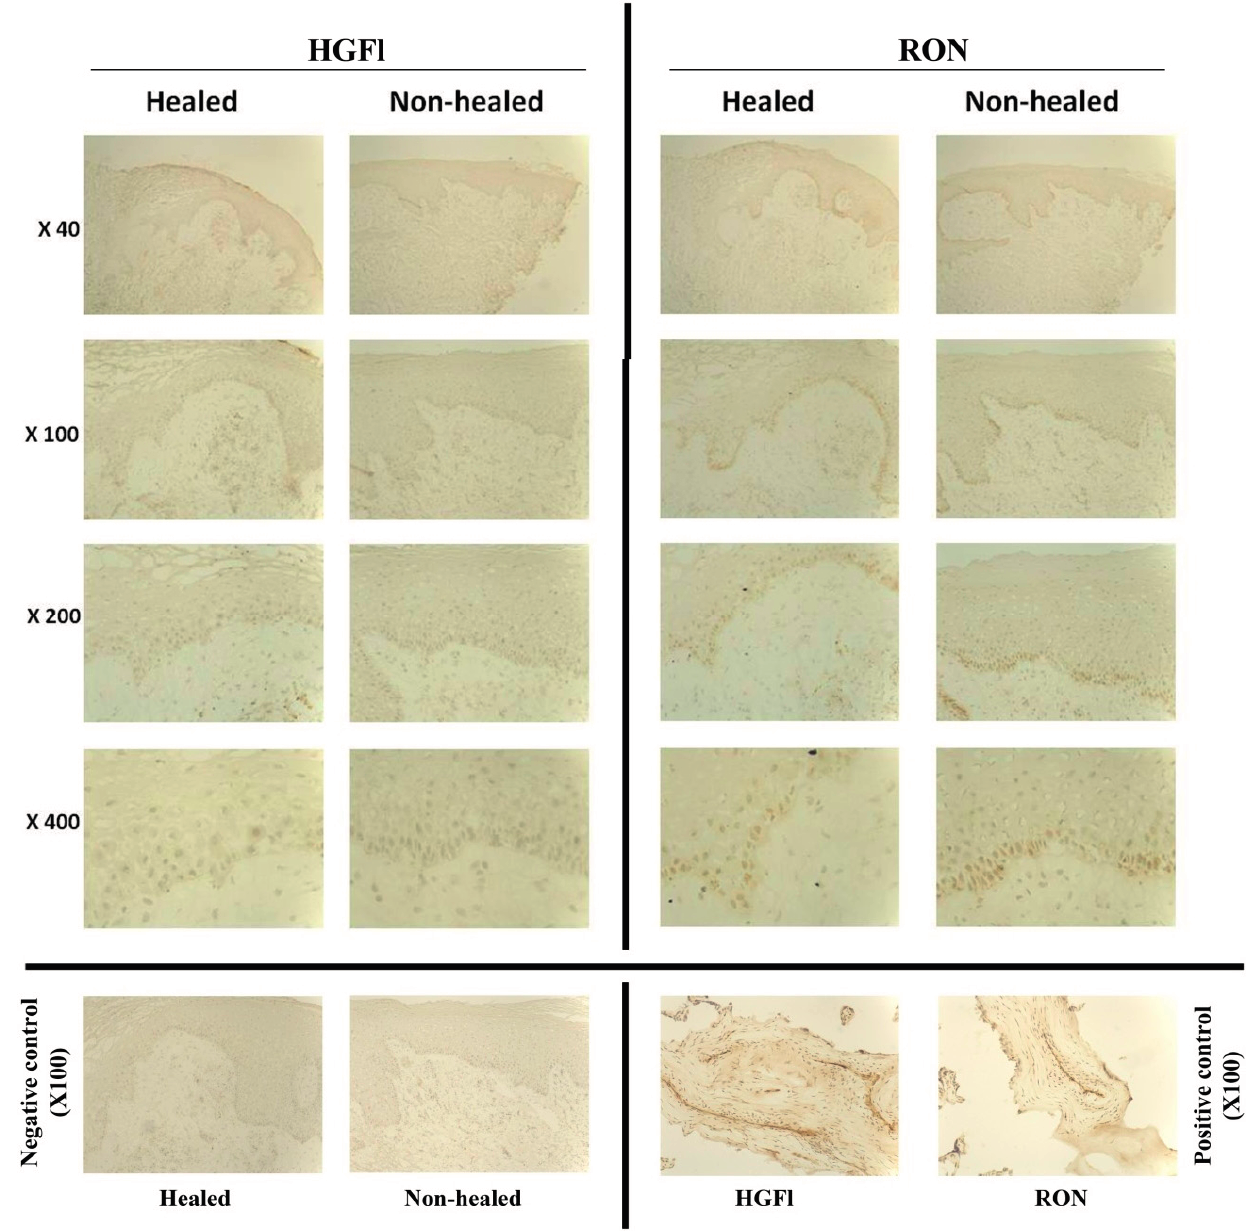
Figure 2. IHC staining for HGFl/RON in chronic healing/non-healing wound tissue. Minimal detection of both HGFl and RON were discovered in both types of chronic wound tissue. No substantial differences were seen in staining intensities of either HGFl or RON between the two types of chronic wound tissues. Negative controls indicate sections stained using secondary antibodies only. Positive controls show placental tissue stained using the respective antibodies. Representative images